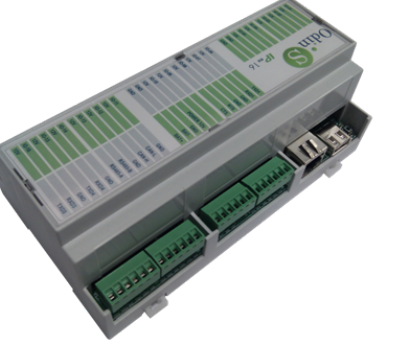
Figure 7. Home automation module